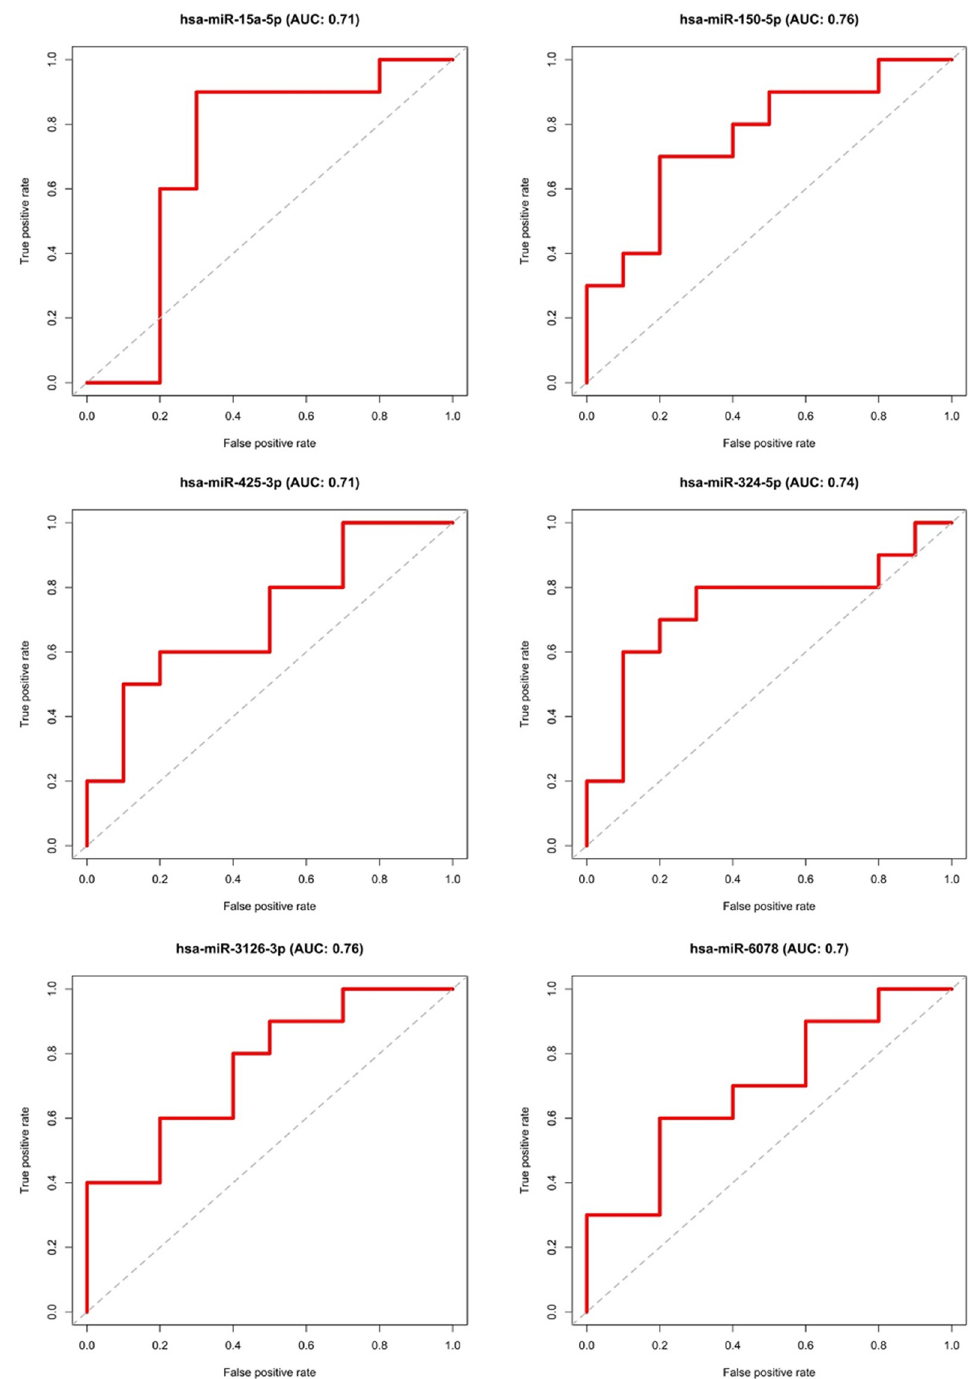
Fig 4. ROC-curves of the validated miRNAs.